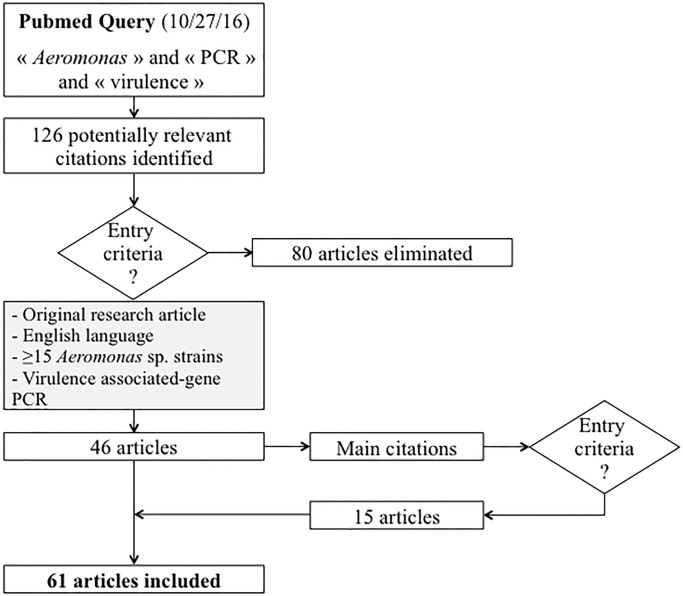
Flowchart for the literature analysis.The automatic Pubmed query using « Aeromonas », « PCR » and « virulence » as keywords generated 126 articles (October 27, 2016), among which 46 corresponded to the entry criteria. The reading of the relevant references quoted in these 46 selected articles led to the manual inclusion of 15 additional articles.